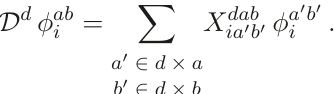
Figure 14 . Defect distributivity. In the second line the factor F 1 b ′ two c -number insertions at the junction points denoted by thick